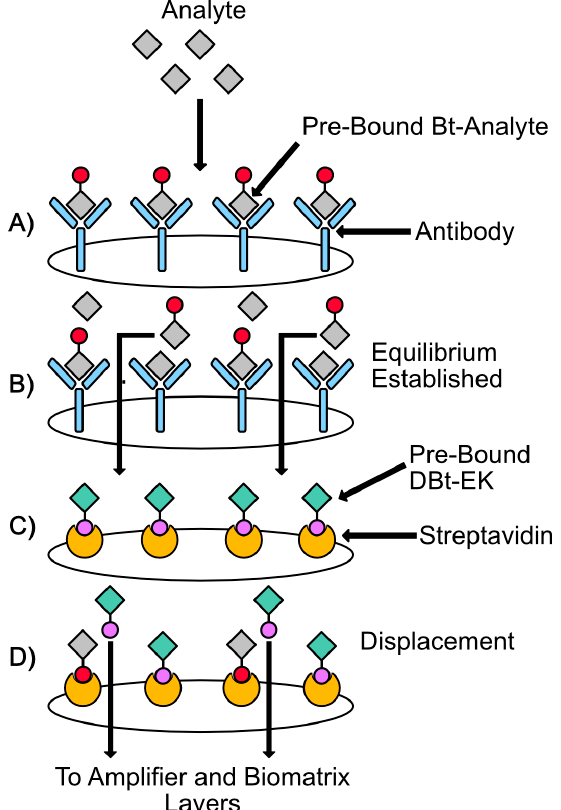
Figure 3. Overview of the selection/competition steps in the complete microPAD design (Figure